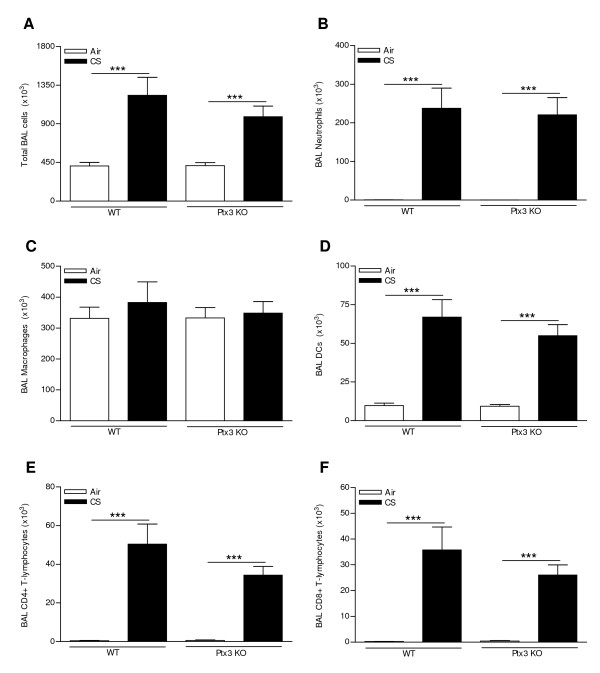
Effect of chronic (24 weeks) cigarette smoke (CS) exposure and PTX3 deficiency on the cell subsets in bronchoalveolar lavage (BAL) fluid. (A) Total cell numbers and numbers of (B) neutrophils, (C) macrophages, (D) dendritic cells, (E) CD4+ and (F) CD8+ T-lymphocytes in WT and Ptx3 KO mice upon 24 weeks exposure to air or CS. Results are expressed as mean ± SEM (N = 10 animals/group; *** p < 0.001). All cell types were enumerated by flow cytometry, except for the neutrophils which were determined by cytospin counts.